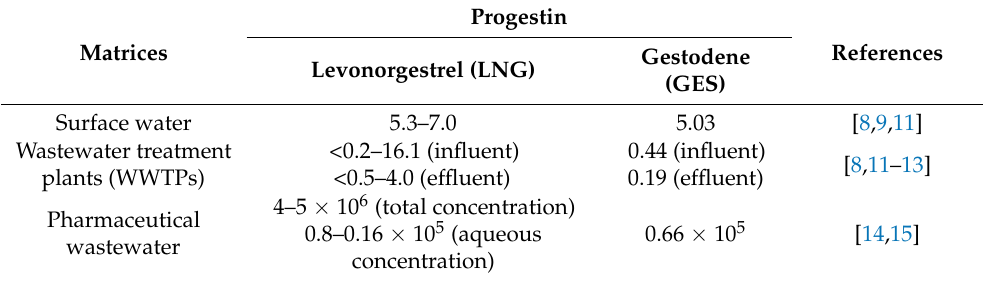
Table 1. Concentration of progestins in water matrices (ng L − 1 ).